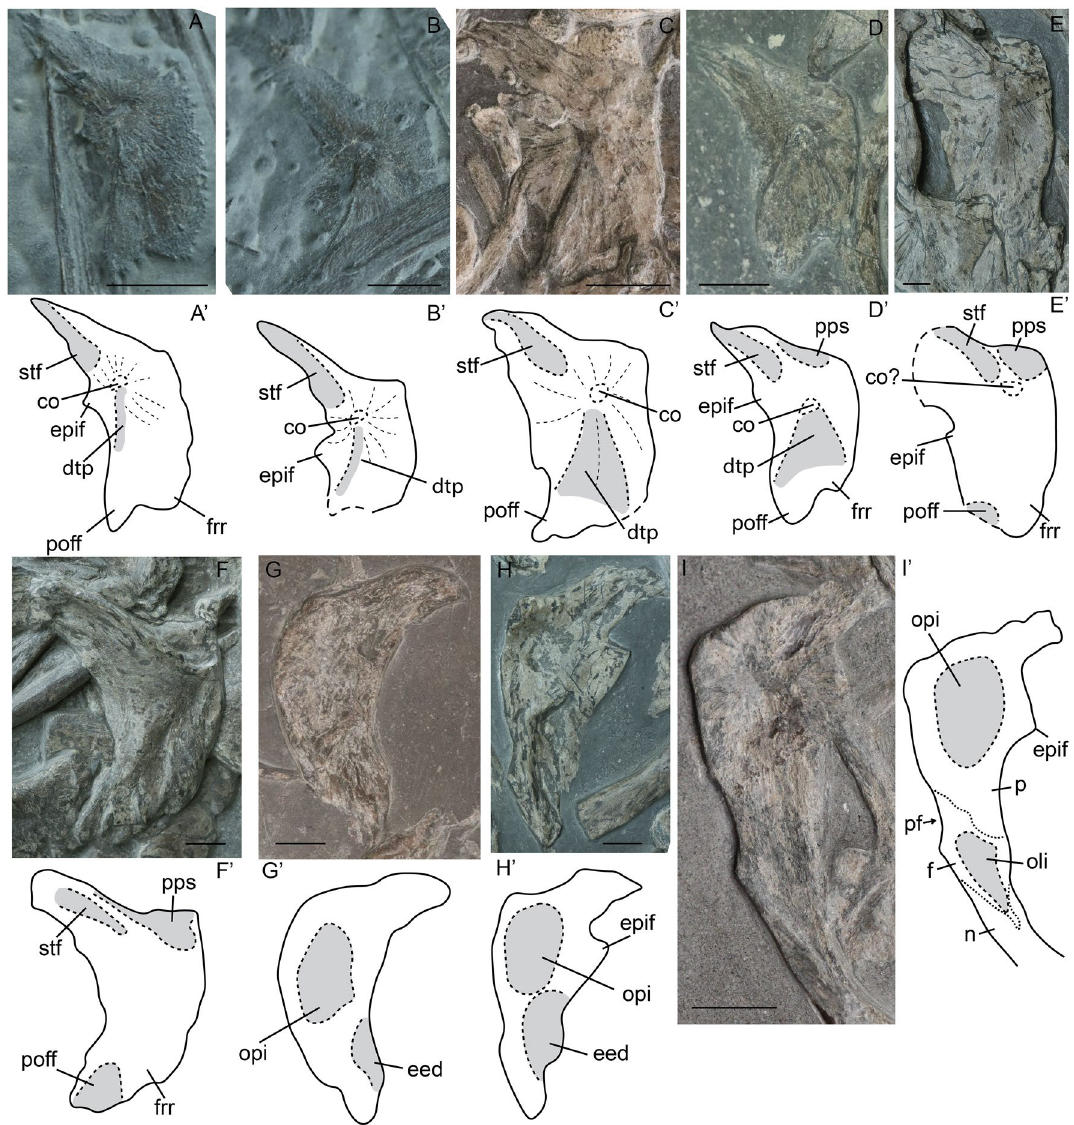
Figure 5. Parietals of selected specimens of Stenopterygius in dorsal ( A – F ) and ventral ( G – I ) view. Interpretative drawings denoted by an apostrophe with their corresponding letter. ( A ) stage 3a embryo S. quadriscissus SMNS 80234; ( B ) stage 3b embryo S. quadriscissus SMNS 80234; ( C ) stage 4 embryo S. quadriscissus SMNS 54062; ( D ) postnatal 1 Stenopterygius sp. SMNS 51140; ( E ) postnatal 2 S. quadriscissus SMNS 54026; ( F ) sexually mature Stenopterygius sp. SMNS 51843; ( G ) postnatal ?2 S. quadriscissus 50183; ( H ) postnatal 2 S. quadriscissus SMNS 51551; ( I ) stage 4 embryo S. quadriscissus SMNS 54064. co centre of ossification, dtp dorsal triangular process, eed extra-encephalic depression, epif epipterygoid facet, f frontal, frr frontal ramus, n nasal, oli olfactory indentation, opi optic lobe indentation, p parietal, pf parietal foramen, poff postfrontal ramus, pps parietal shelf, stf supratemporal facet. Scale bar: ( A – I ) = 10